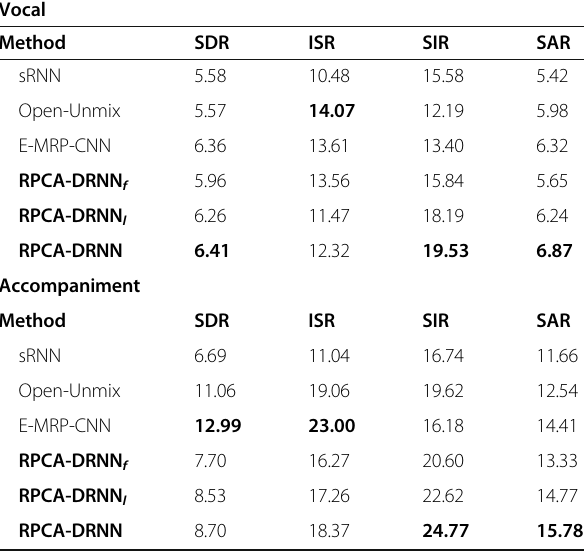
Table 7 Comparison of the SDR, ISR, SIR, and SAR scores of the proposed RPCA-DRNN methods with sRNN, Open-Unmix, and E- MRP-CNN on